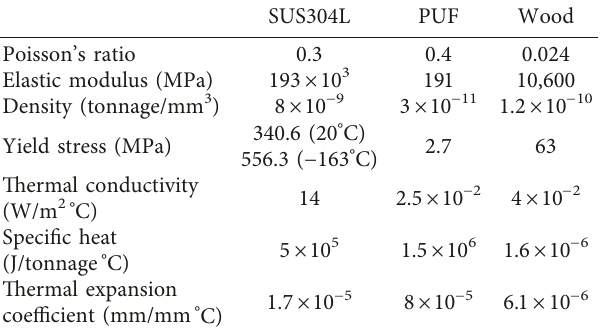
Figure 4: Schematic presentation of the structural design and size of a type-B independent tank. Table 2: Mechanical and thermal properties of materials of tank